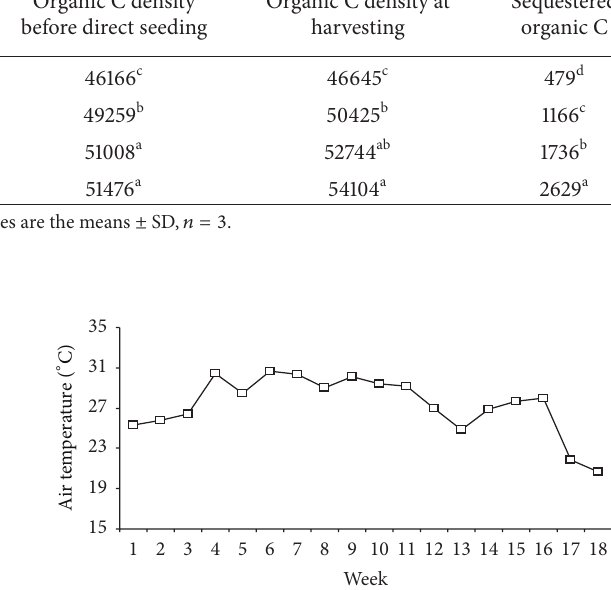
Table 1: Differences in soil total organic C (g kg − 1 ), organic C density (kgCha − 1 ), and sequestered organic C (kgCha − 1 season − 1 ) during a rice-growing season from NT paddy fields under different residue mulching treatments. Total organic C Total organic C Organic C density Organic C density at Sequestered Treatments concentrations before concentrations at before direct seeding harvesting organic C direct seeding harvesting 0 RRM